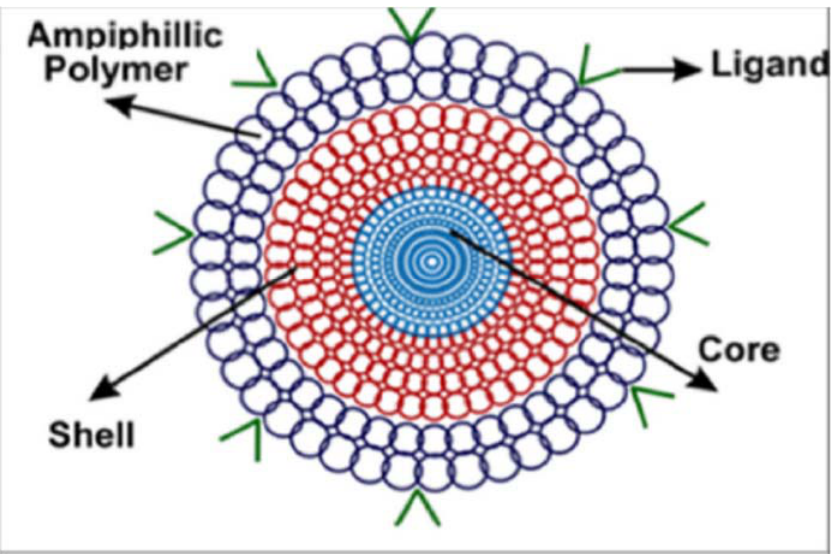
Figure 1. Semiconductor quantum dots . Reprinted with permission from Ref. [19]. Copyright 2021 Elsevier.